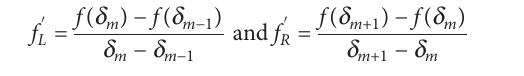
Table 1 . Enrolled breast cancer patient information: age, planning dose, fi eld, time course, and all their depth error. All patients are two- fi eld cases. Patients may have different delay times before positron emission tomography scanning, but the data acquisition (Acq) time is the same for all cases. The D R 50 and D R shift are scored in the CTV region and boost region (if exist). Different dose distribution strategies: Uniform: a dose is